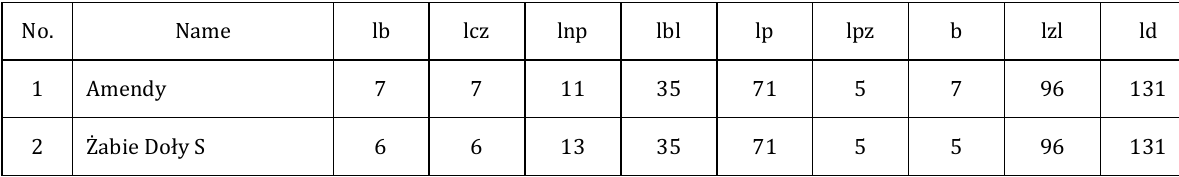
Table 1. The ice formation phases of both water bodies in the winter season of 2011/2012